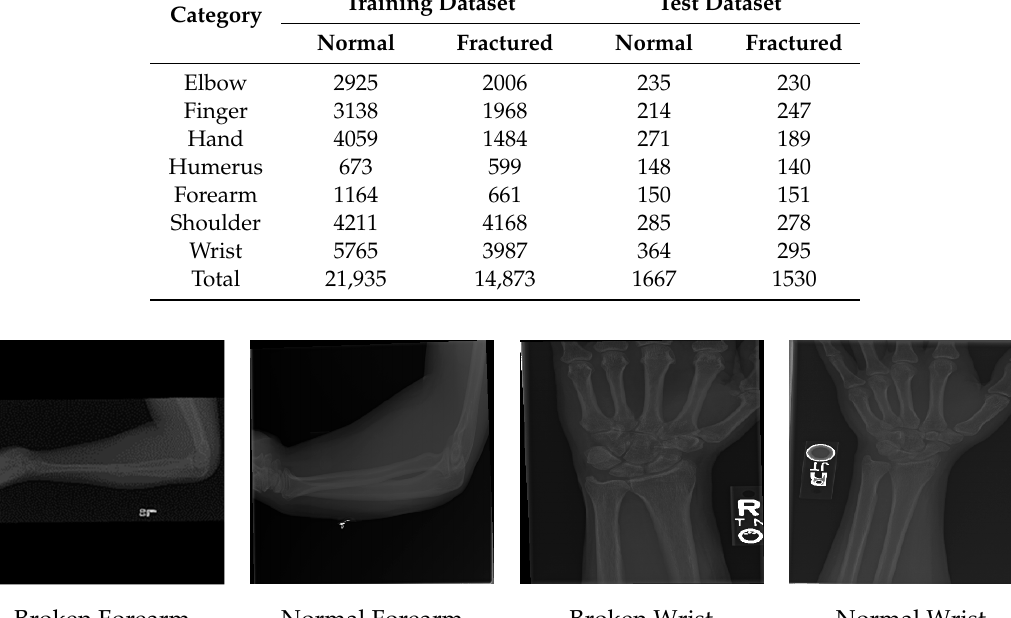
Table 1. MURA dataset summary.